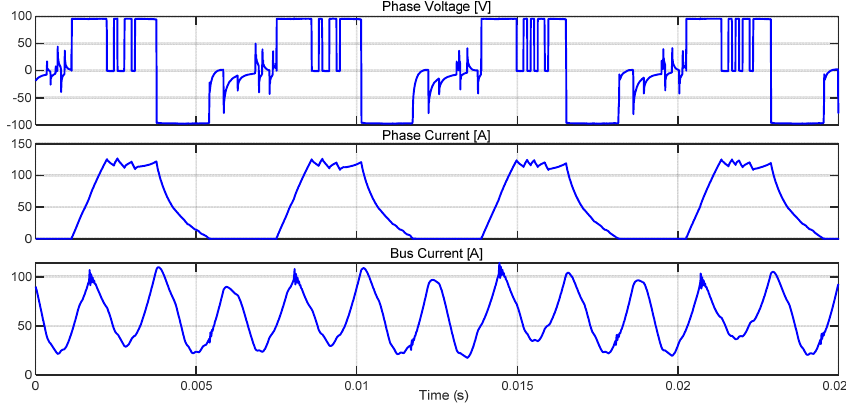
Figure 20. Experimental waveforms of phase current, phase voltage and bus current for 900 rpm, 30 Nm with hysteresis control θ ON = − 7°, θ OFF = 8°.